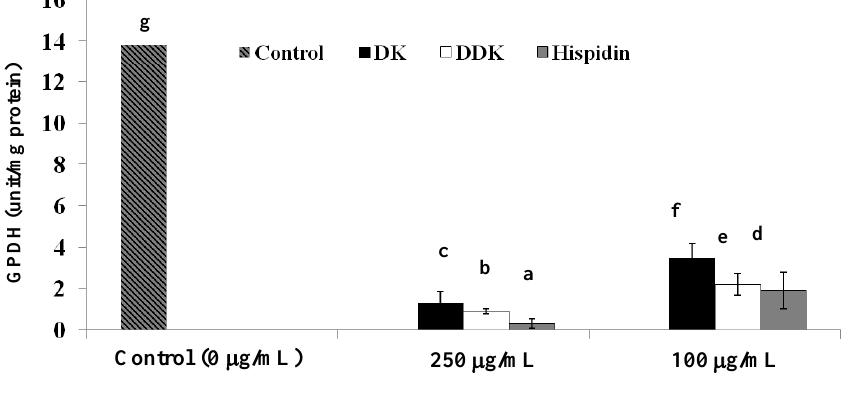
Figure 8. The effect of the hispidin, DK and DDK on the inhibition of GPDH activity in 3T3-L1 adipocytes. Cells were treated with 100 and 250 µg/mL tested compounds for 72 h and incubated at 72 h at 37 °C in a humidified incubator containing 5% CO 2 . Reported values are the mean ± SE ( n = 3). Letters with different superscripts indicate samples that are significantly different ( p < 0.05) than the